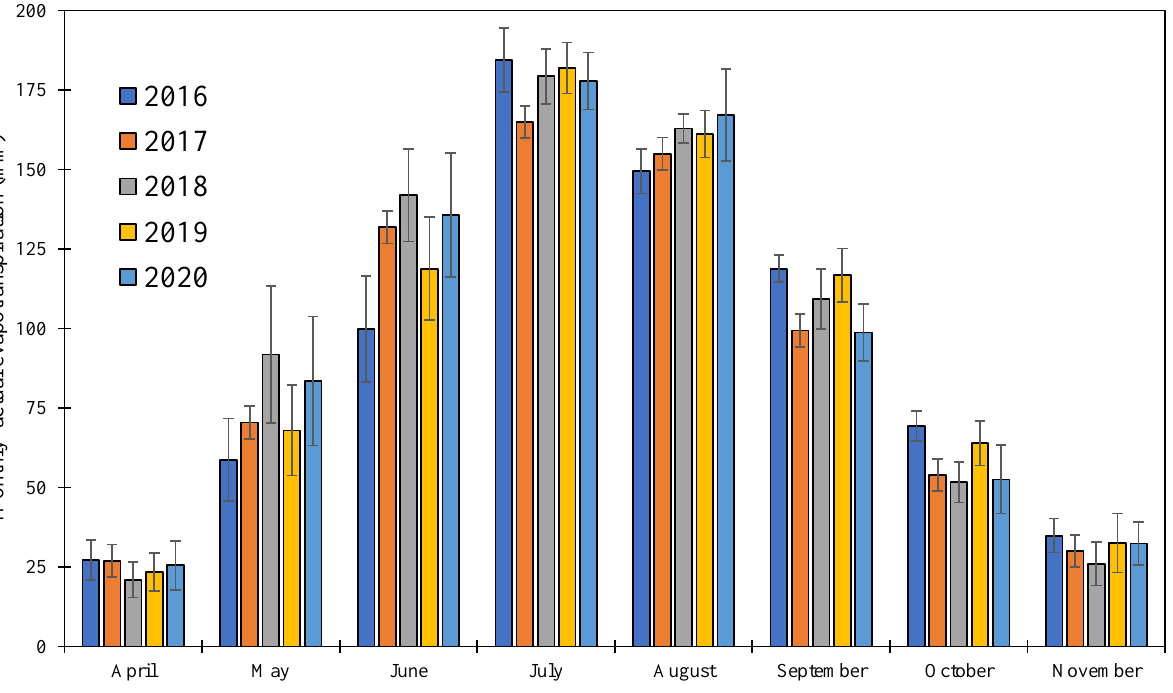
occurred in July. Depending on the planting date and or variety, tuber initiation may start as early as May and continue to the bulk stage, and most tubers mature by mid-August, with senescence occurring by the end of August for the early maturing potato varieties. Starch accumulation continues with the mid- to late-maturing varieties, and the potato vine is usually killed at the end of August – early September. However, light irrigation continues for at least two weeks to reinforce the buildup of the potato tuber skin before harvest with an increase in soil water evaporation before tuber harvest. The seasonal po- Figure 5. Monthly actual maize crop evapotranspiration with standard deviation among twenty-two maize fields for the 2016 – 2020 period under center-pivot irrigation. Potato planting starts in early April and finishes in early May, while soil preparation, soil treatment for soilborne diseases, and nematode control and seedbed preparation start in March. Planting and harvesting mostly depend on resource availability, and their oc- currence may vary from year to year with harvesting in late September – early October before the first fall frost. After the planting of potatoes, irrigation is very limited because the moisture in the potato seed is enough for potato sprouting and emergence. Soil water evaporation is, therefore, limited, and transpiration is almost null in April. Potato ETa increased with crop emergence and growth and development and averaged 21.5, 61.4, 151.3, 176.4, 126.8, and 63.5 mm in April, May, June, July, August, and September, respec- tively, for the 2016 – 2020 period (Figure 6). Like maize, the potato's monthly peak ETa